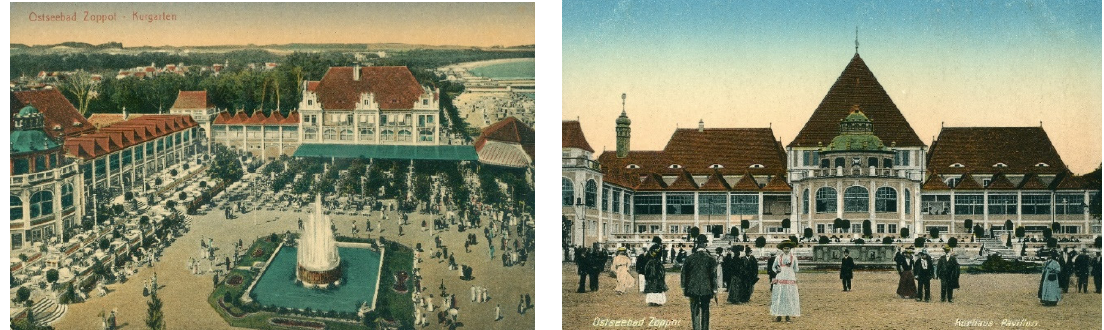
Figure 4. Public space in Sopot. Source: Fotopolska.eu.